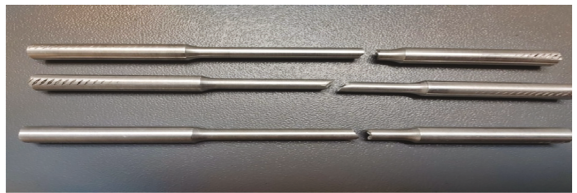
Figure 15: Specimens after tensile